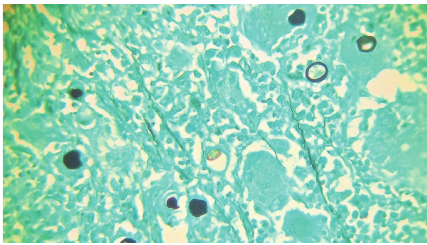
Figure 5: C. Grocott staining confirming the presence of large bodies of C . immitis in black (Grocott).